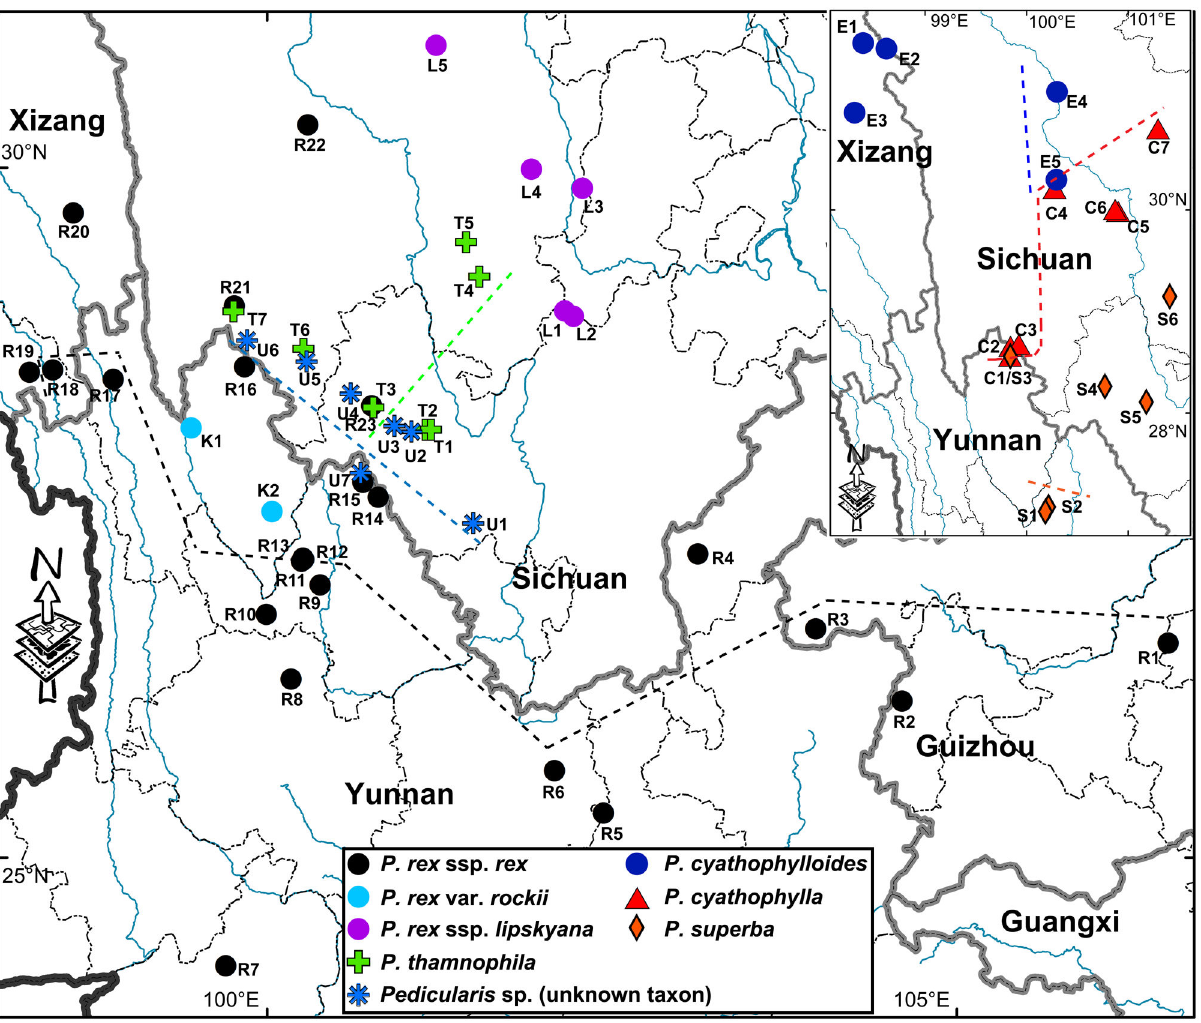
Figure 3. Geographical information for studied samples of Pedicularis section Cyathophora . Detailed collection of sample code is presented in Table S1. The black, green and light blue dash lines separates sample of P . rex subsp. rex , P. thamnophila and the unknown taxon in accordance with the nrITS phylogeny, respectively; and the blue, red and orange dash lines separates samples of P. cyathophylla , P. cyathophylloides and P. superba in accordance with the chloroplast phylogeny,